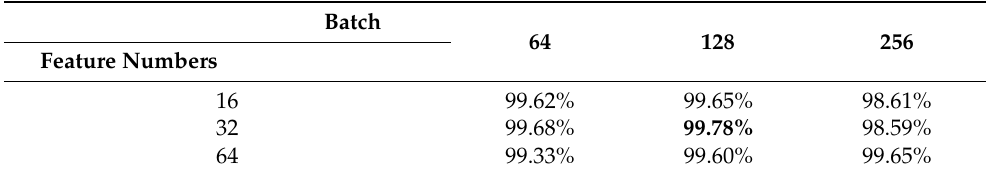
Table 2. The example of classification accuracy in MIT-BIH-AR database under different hyperpa- rameter setting (record 100).